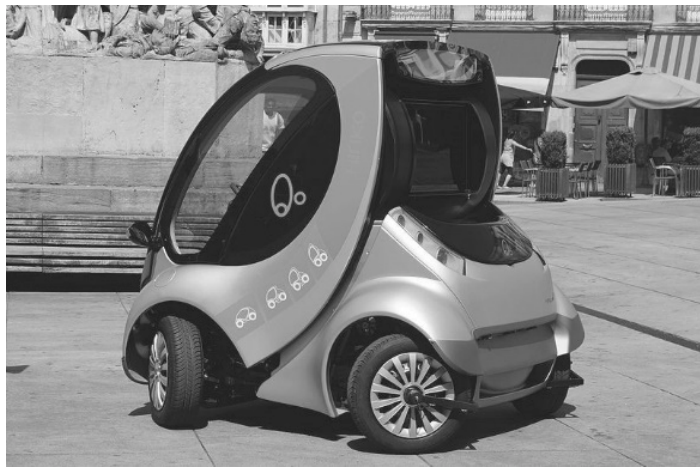
Figure 14. Hiriko Fold—a vehicle employing in-wheel motors.